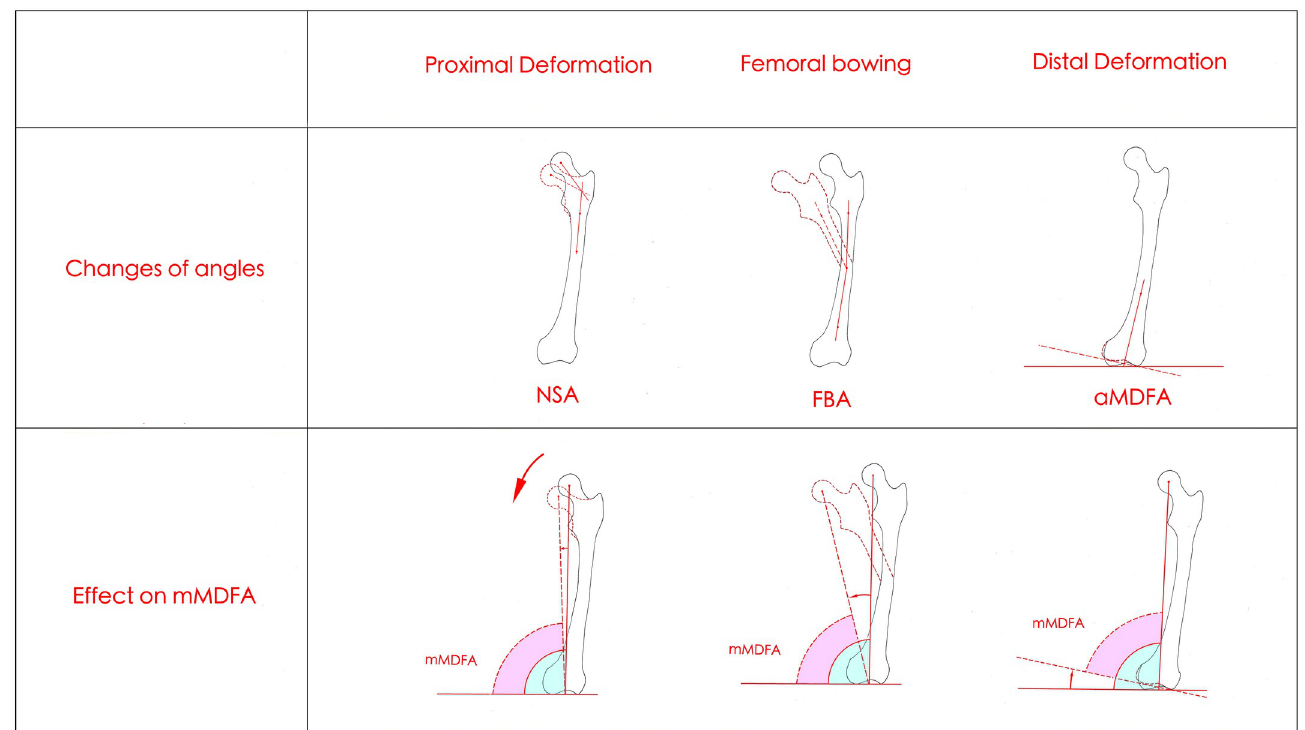
Fig 2. Three morphology changes effect the mMDFA. Proximal deformation (NSA changes): a decreasing NSA leads to a decreasing mMDFA; Femoral bowing (FBA changes): an increasing FBA leads to a decreasing mMDFA. Distal deformation (aMDFA changes): a decreasing aMDFA leads to a decreasing mMDFA.